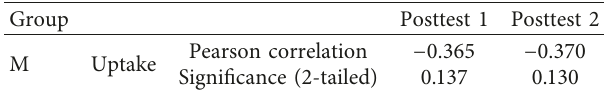
Figure 1: Means plot for performance of the groups at three time Table 11: Correlations between measures of uptake and posttests for the M group.